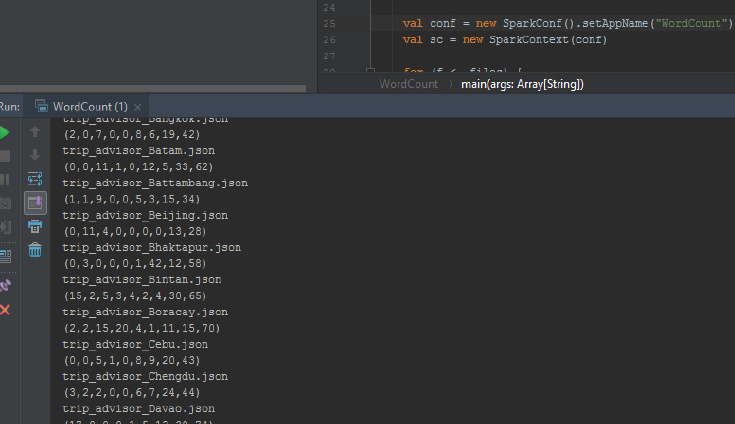
Figure 11. A sample screenshot of functions created and count of keywords extracted.